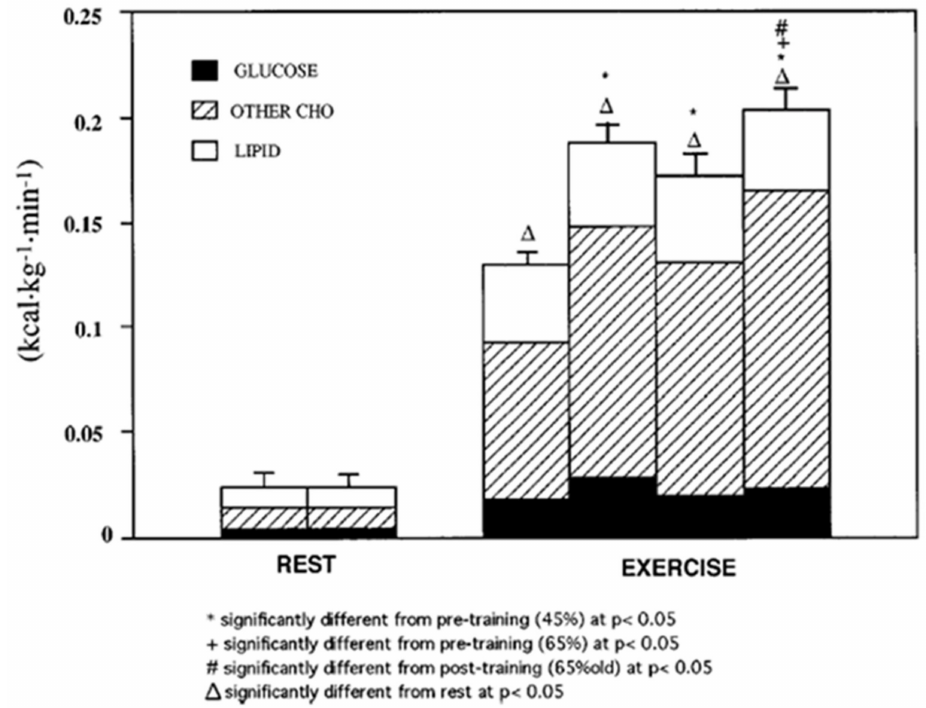
Figure 2. Energy generated from oxidation of carbohydrate (CHO) and lipid sources. Subjects were studied at 45 and 65% of peak rate of oxygen consumption (VO 2 peak) before 9 week of endurance training (45% pre and 65% pre, respectively) and then after training at same absolute power output that elicited 65% VO 2 peak before training (65% old (absolute, ABT)) and same relative power output that elicited 65% VO 2 peak after training (65% new (relative, RLT)). Error bars, SE for total energy expenditure only; n = 10 subjects. Note that compared to rest, energy expenditure during exercise increases more than 10 times. Note also that at rest glucose oxidation represents approximately half of total CHO oxidation that represents only 25% of energy expenditure. During exercise glucose oxidation represents only 10–20% of total energy expenditure and approximately 25% of total CHO oxidation. From